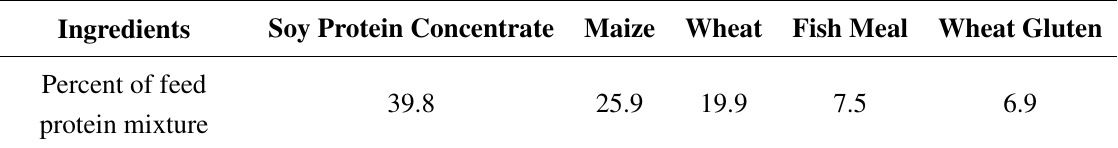
Table 1. Constant mixture of feed protein sources in the experimental diets with graded dietary protein supply [11].